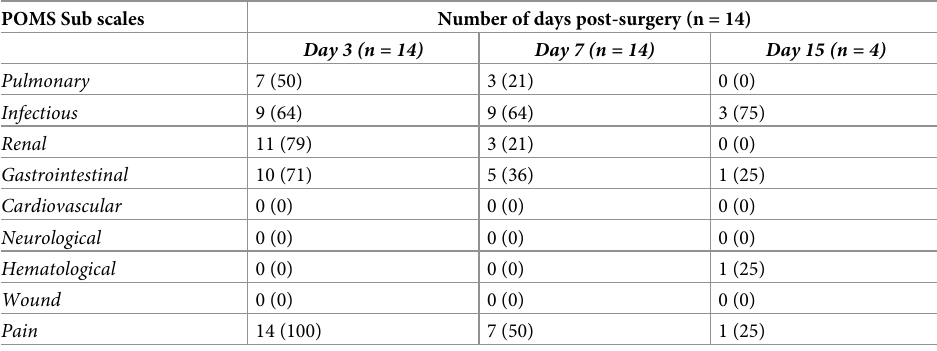
Table 5. Post-operative outcome data. POMS Sub scales Number of days post-surgery (n = 14) Day 3 (n = 14) Day 7 (n = 14) Day 15 (n = 4) Pulmonary 7 (50) 3 (21) 0 (0) Infectious 9 (64) 9 (64) 3 (75) Renal 11 (79) 3 (21) 0 (0) Gastrointestinal 10 (71) 5 (36) 1 (25) Cardiovascular 0 (0) 0 (0) 0 (0) Neurological 0 (0) 0 (0) 0 (0) Hematological 0 (0) 0 (0) 1 (25) Wound 0 (0) 0 (0) 0 (0) Pain 14 (100) 7 (50) 1 (25) Data are presented as n (%) and median (IQR). The sub scales represent nine domains of post-operative morbidity. Abbreviations: POMS (post-operative morbidity